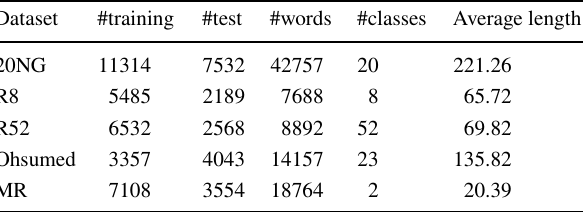
Table 1 Statistical information of the five text classification datasets Dataset